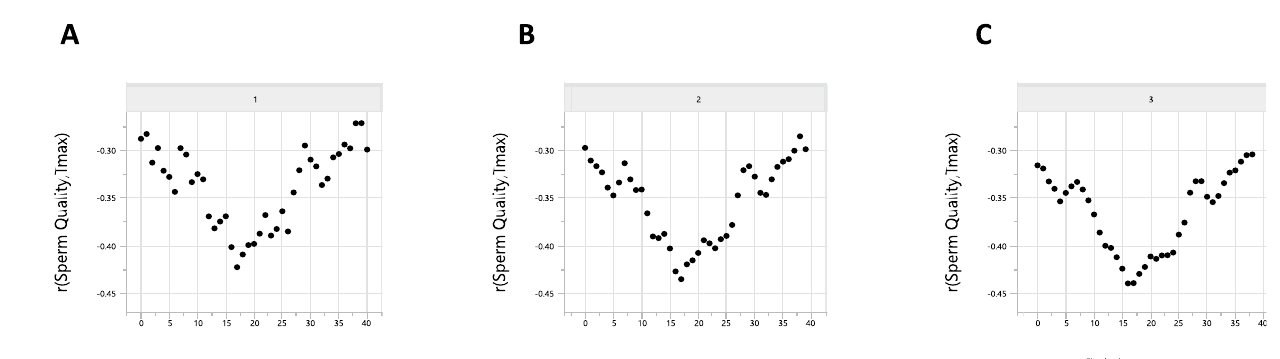
Figure 5. Heating of Wagyu bulls to identify heat-sensitive and heat-tolerant effect. Twenty Wagyu bulls all 3 years of age and over were heated to 40 °C for 12 h in an insulated barn. Before heating, bassline samples were taken (week 1). After heating, electroejaculation was used to collect semen every week for 11 weeks. For every sample, sperm morphology was counted by a qualified theriogenologist. The data show the percentage normal morphology for 5 bulls. The light blue line indicates a heat-sensitive bulls, whose morphology was affected by heat, then returned back to baseline. The orange and grey line represent two related bulls (same father) who also produced less than 70% normal forms. The yellow, green and dark blue lines represent three heat-tolerant bulls, whose semen profile did not drop below the 70% normal spermatozoa threshold.